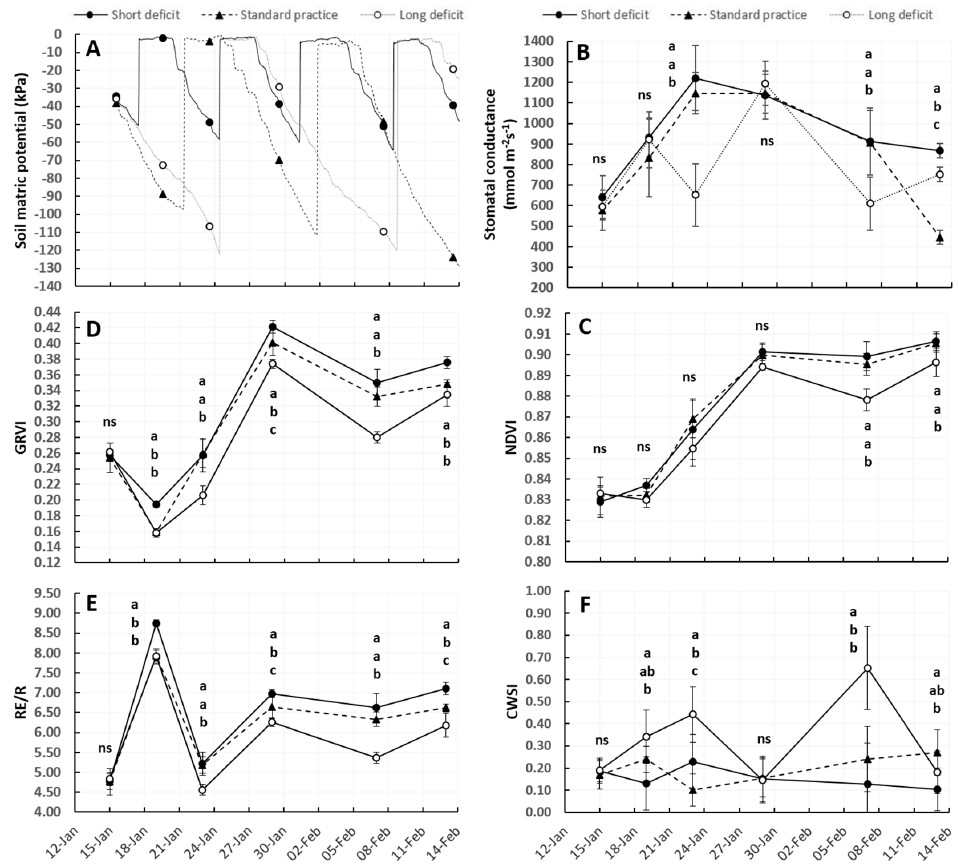
Figure 4. Mean values of ( A ) soil matric potential, ( B ) stomatal conductance and the multispectral vegetation indices ( C ) NDVI, ( D ) GRVI, ( E ) RE / R and ( F ) the CWSI for each irrigation treatment and measurement date during the 2017 / 18 growing season. Graph A also shows the evolution of the soil matric potential for the period when all the measurements were taken (from 15 January to 13 February 2018). Dates when soil matric potential returns to values < − 10 kPa are indicative of an irrigation event. Different letters within a measurement date, indicate statistical significant differences between treatments at p < 0.05. The letter on the top refers to the highest value whereas the letter on the bottom refers to the lowest. No statistically significant differences are indicated by “ns”. Vertical bars indicate the standard deviation for each treatment and date.